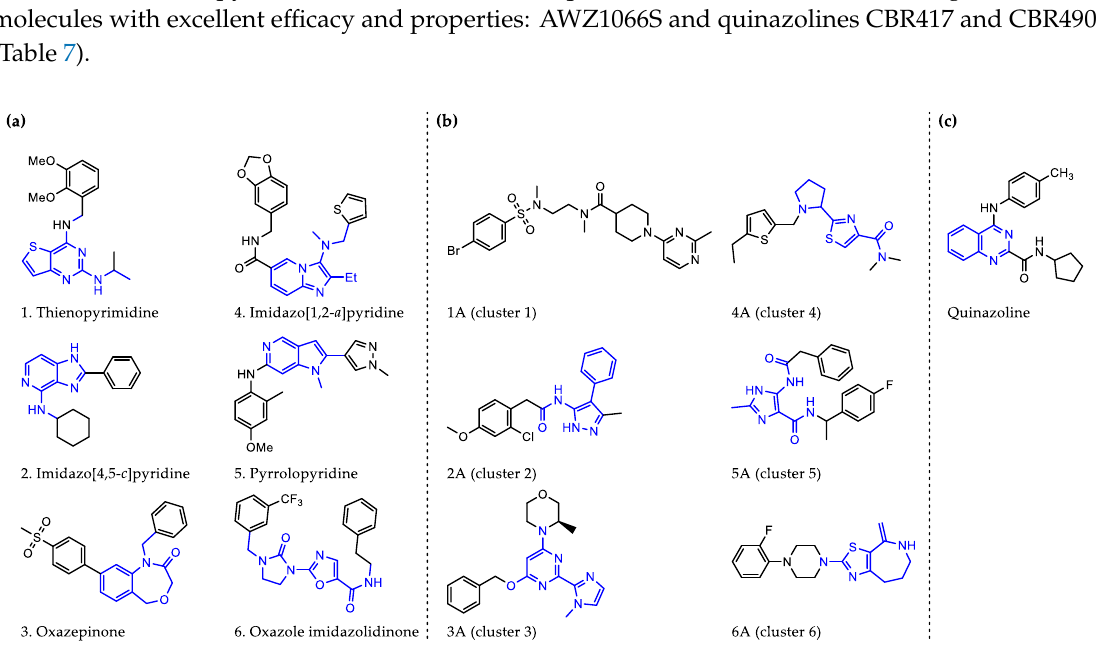
Figure 2. Representative structures of published antiwolbachial hit series identified in insect cell-based high-throughput screens with the cores of each series highlighted in blue. Series identified in screens using: ( a ) C6/36 insect cells with w Alb quantified using qPCR and Syto 11 high content imaging assay [87] ; ( b ) C6/36 insect cells with w Alb quantified using immunofluorescence ( w BmPAL antibody staining) [90] ; ( c ) LDW1 insect cells with w Mel quantified using 16S rRNA FISH [92] .